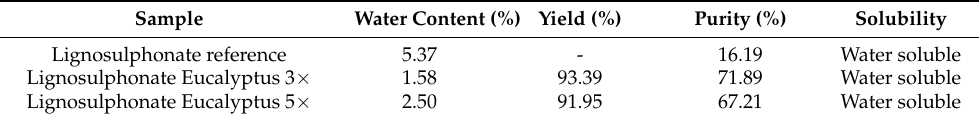
Table 2. Chemical components of lignosulphonate after 3 × and 5 × washing